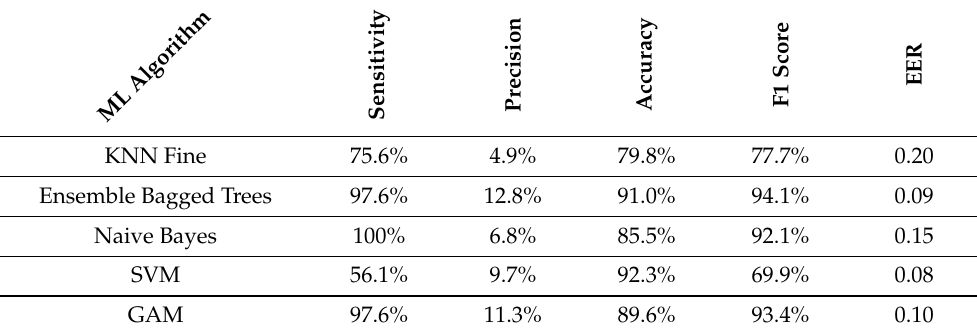
Table 6. PPG Result Details—Single User